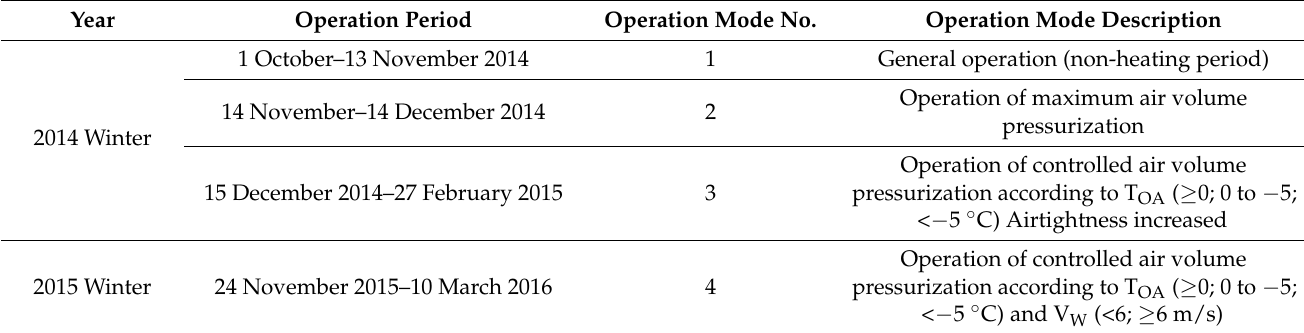
Table 1. Summary of operation modes utilized to develop a method for reducing stack